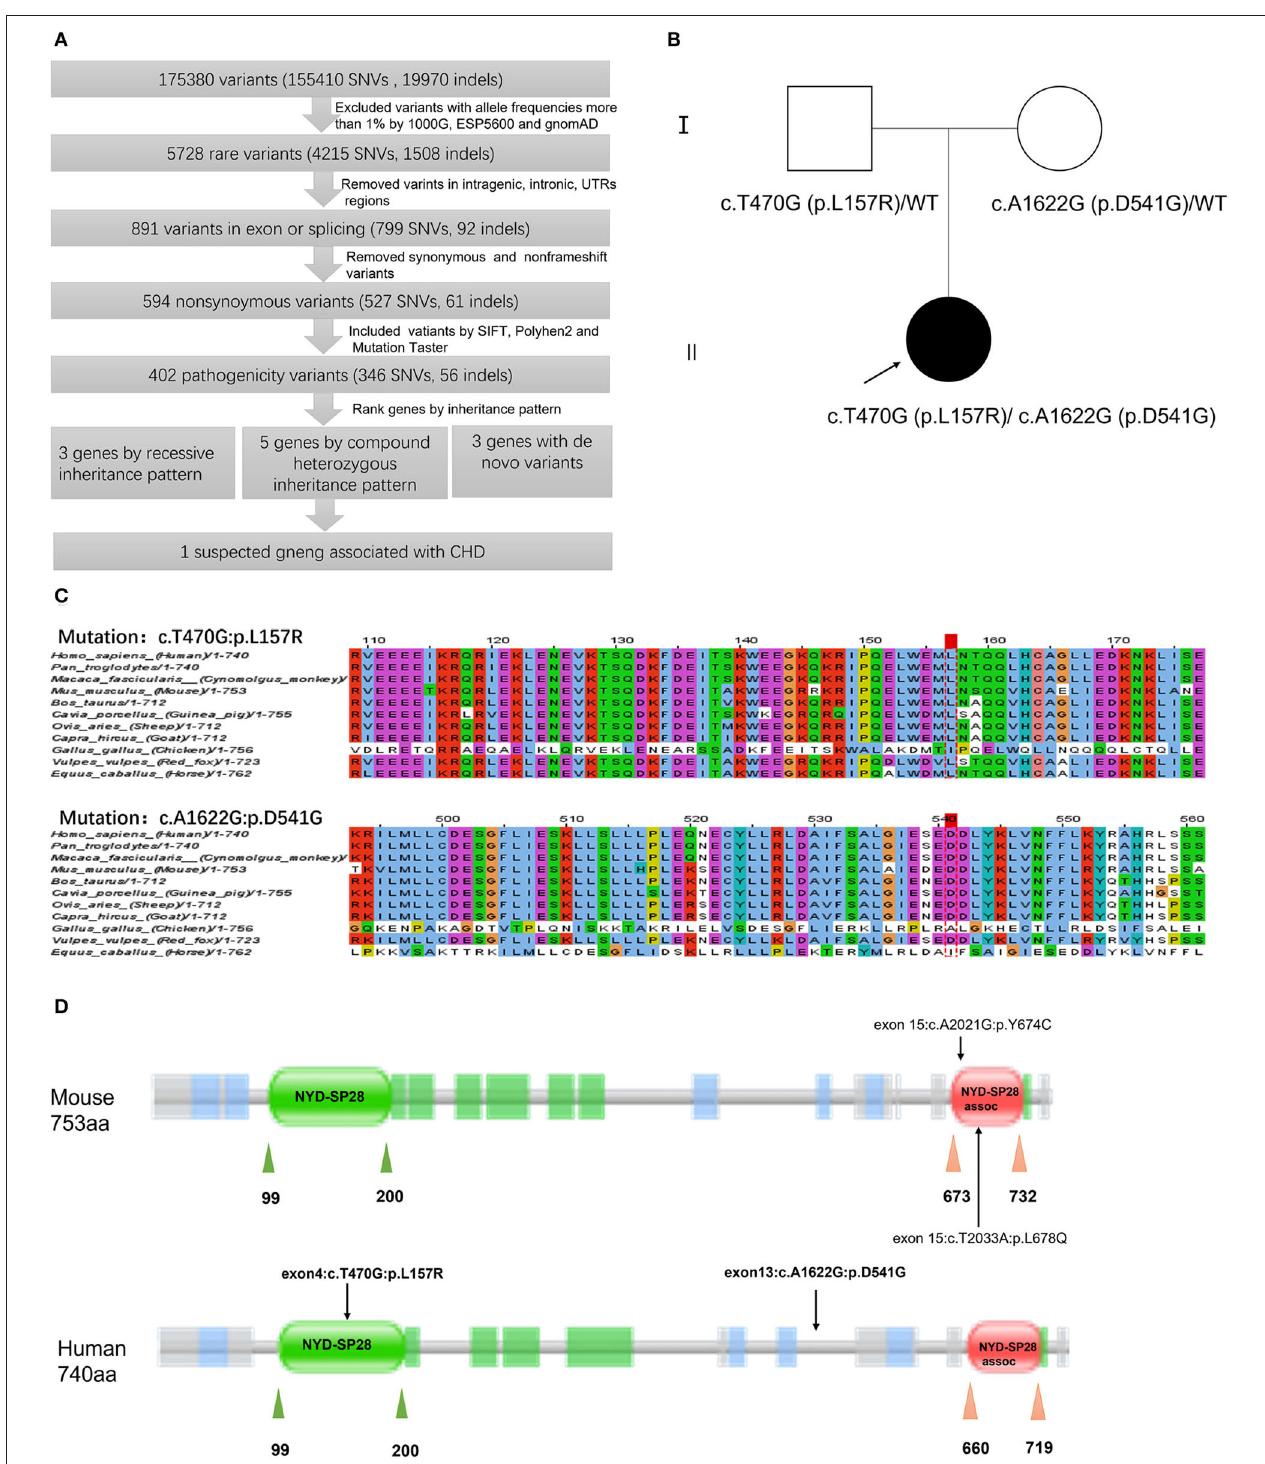
FIGURE 3 | Schematic diagram of filtering strategies in our report. Several variant filtering processes and candidate gene prioritization were applied. Only one candidate gene was associated with CHD (A) . Pedigrees of the patient’s family. The filled and unfilled symbols represent subjects with and without CHD, respectively. Arrow indicates the proband of the family. DRC1 genotypes are shown near each symbol, WT represents wide type (B) . Multiple sequence alignment of the DRC1 protein sequences indicates the Leu157 residue and Asp541 residue are highly conserved among various species (C) . Schematic of domains within DRC1 protein. Rare variants p.L678Q and p.Y674C in DRC1 had been identified in CHD mouse by Li et al. (14), while compound heterozygous variant, c.T470G (p.L157R) and c.A1622G (p.D541G), in DRC1 was identified in our patient of which c.T470G (p.L157R) variant was lined in NYD-SP28 domain (D) .